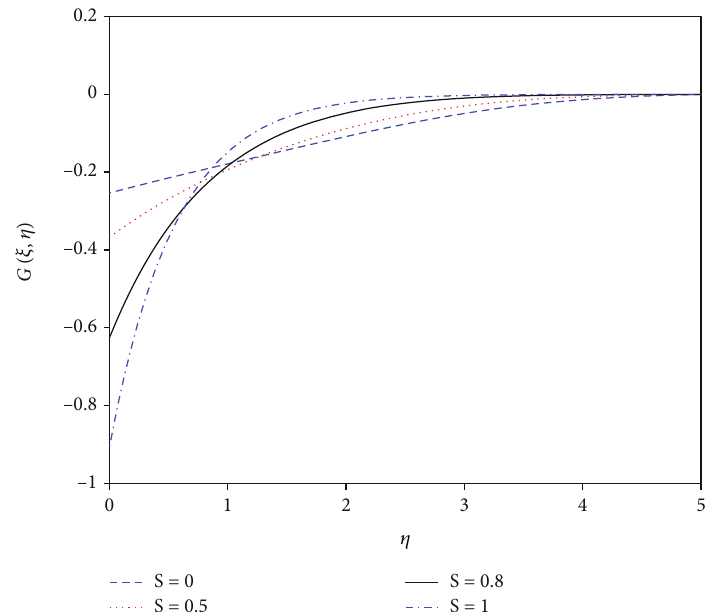
Figure 7: Microrotation pro fi le G ð ξ , η Þ for di ff erent values of transpiration parameter S , when K = 0 : 5, ξ = 5, Pr = 10, n = 0 : 5, Ω = 0 : 1, N